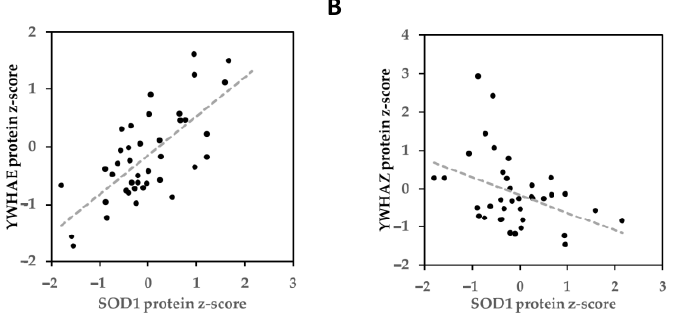
Figure 7. The correlation analysis on SOD1-YWHAE and SOD1-YWHAZ. ( A ) The scatter plot by standardized protein z-score of SOD1 versus YWHAE based on breast cancer proteomic dataset, r = 0.71, p -value = 3.05 × 10 − 7 . ( B ) The scatter plot by standardized protein z-score of SOD1 versus YWHAZ based on breast cancer proteomic dataset, r = − 0.40, p -value = 0.015.